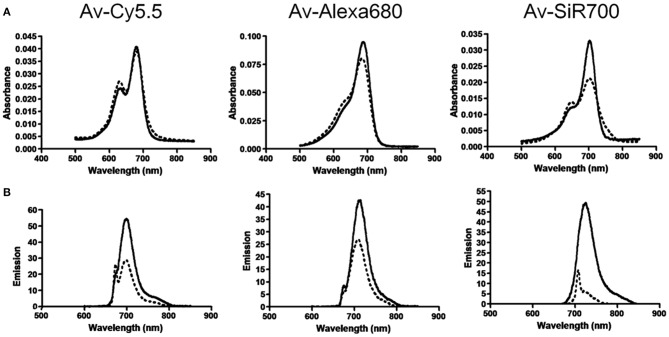
(A) Absorbance spectra of near-infrared (NIR) imaging probes, consisting of a NIR fluorophore conjugated to avidin, without SDS (dashed line) and with SDS (solid line). (B) Emission spectra of NIR imaging probes without (dashed line) and with (solid line) SDS (McCann et al., 2011). Reproduced with permission. Copyright 2011 American Chemical Society.